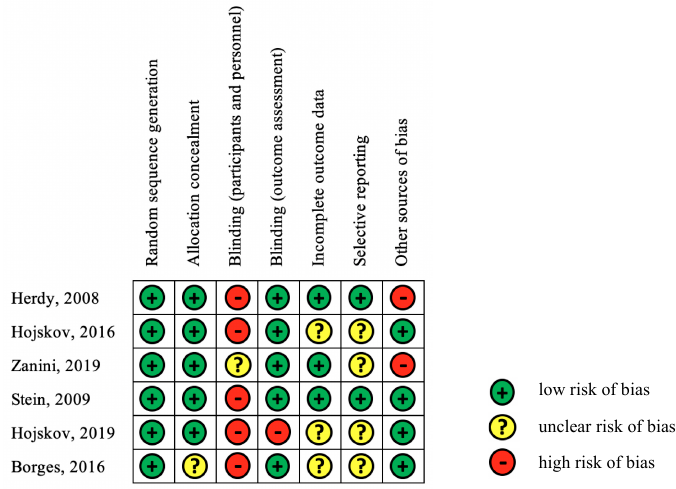
Figure 3. Summary of the risk of bias in the analyzed studied.